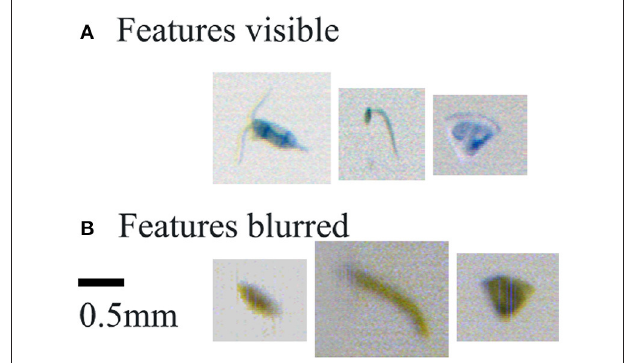
FIGURE 7 | PIA images of specimens of similar size, but with features used for class identification (A) Features visible: from left to right, Paracalanus/Pseudocalanus , appendicularia, and bryozoan. (B) Features blurred: for images that lack distinguishing features, the taxonomist observes the triangular object, although bryozoan-looking, is most likely detritus as the internal structures cannot be